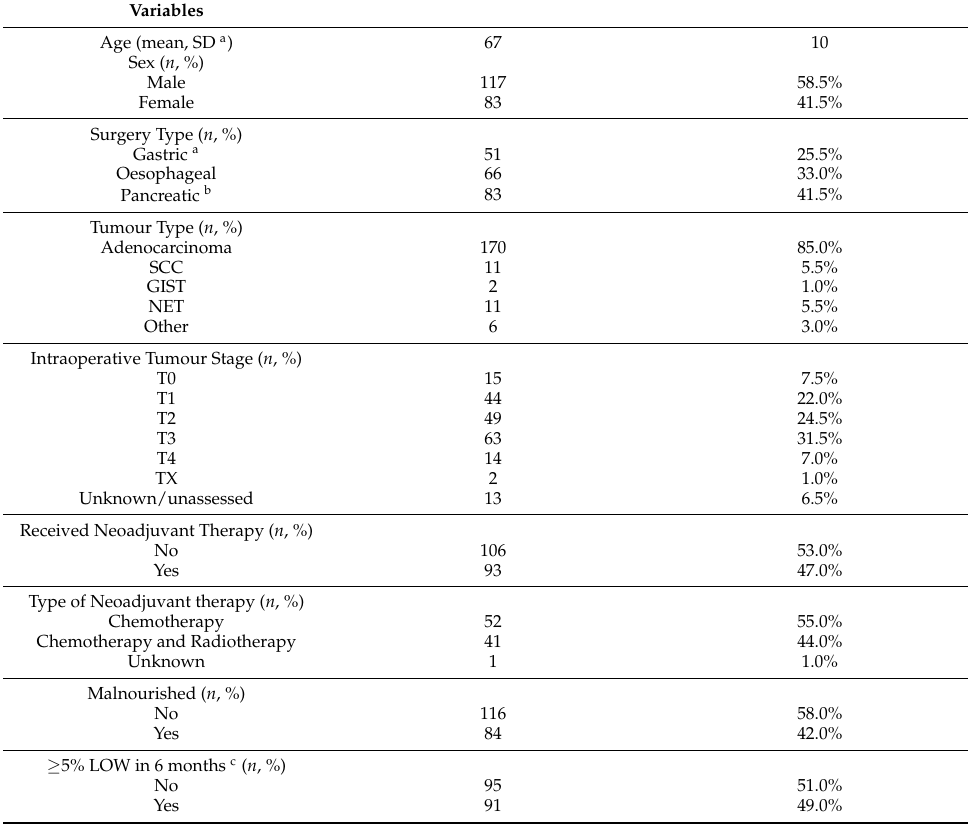
Table 1. Baseline clinical characteristics of the cohort ( n =